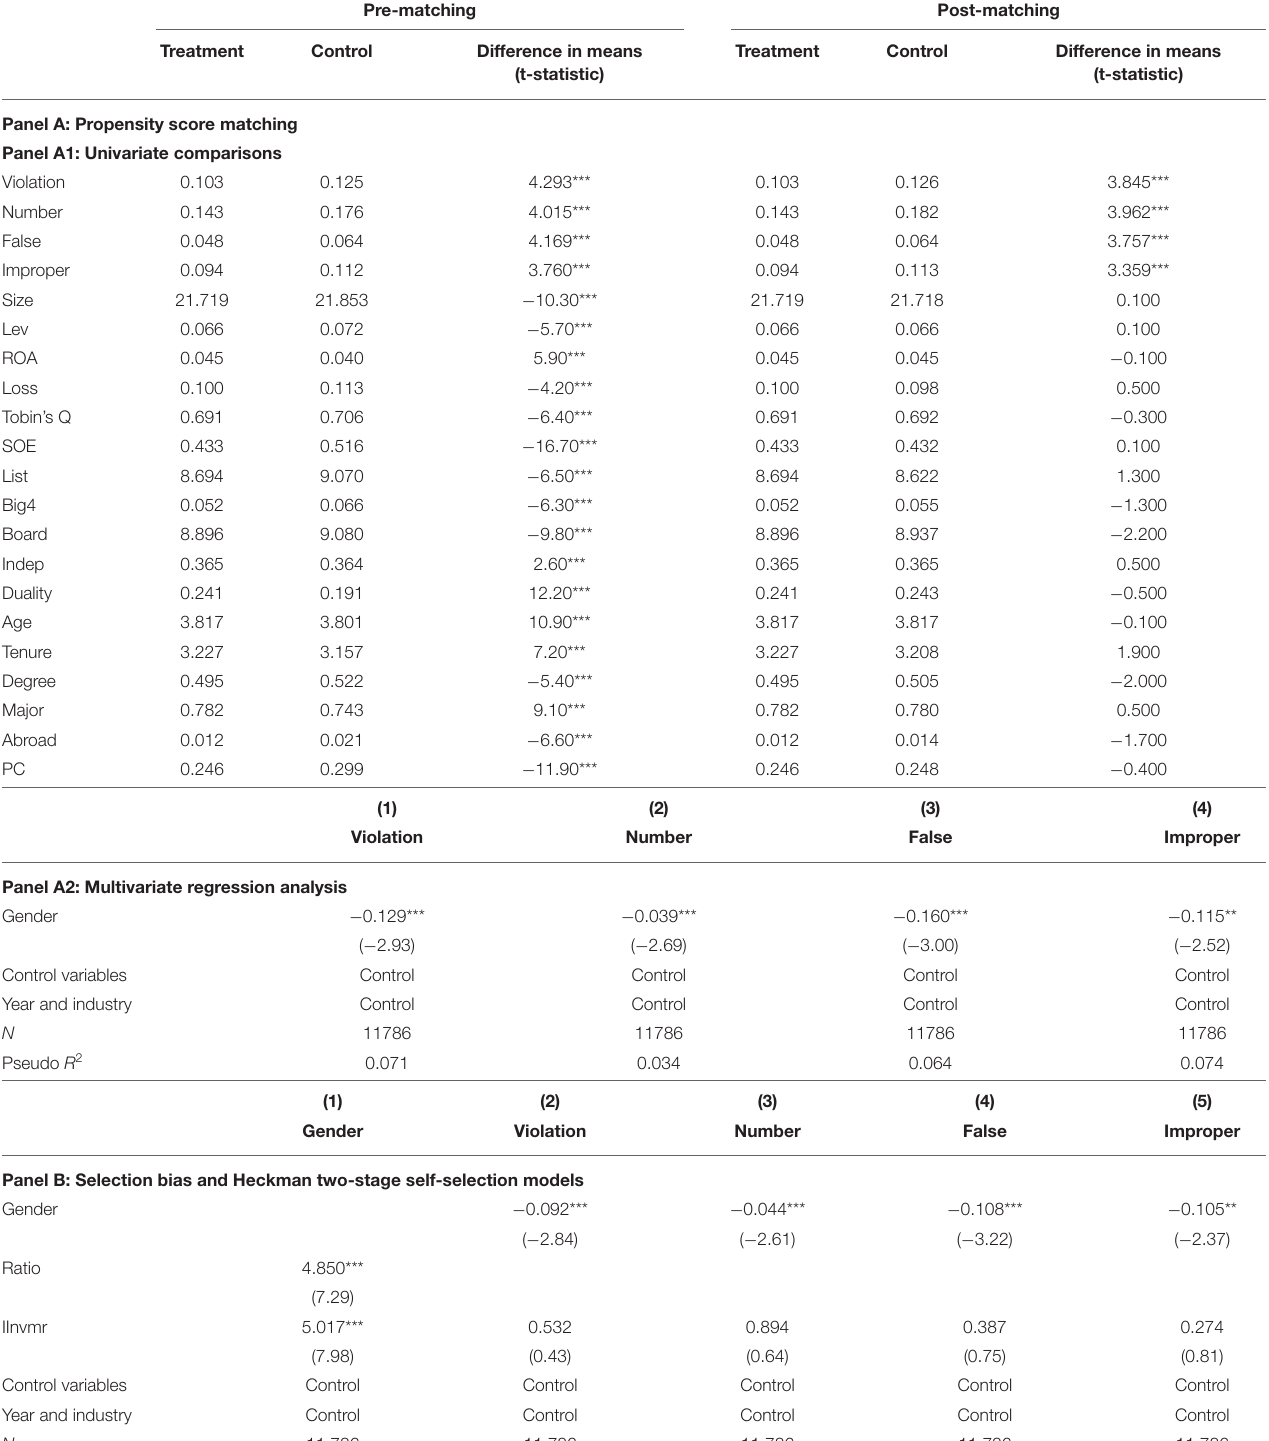
TABLE 5 | Robust checks. Pre-matching Post-matching Treatment Control Difference in means Treatment Control Difference in means (t-statistic)